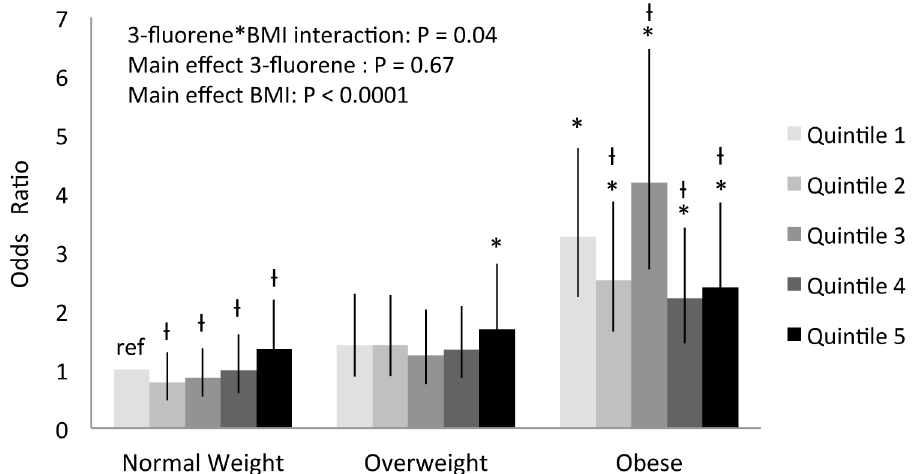
Fig 1. Weighted and adjusted odds ratio for hypertension and 3-fluorene quintiles by weight status. Weighted and adjusted for age, sex, poverty income ratio, ethnicity, smoking status and urinary creatinine. * Significantly different from normal weight in the lowest 3-fluorene quintile (reference group), P (cid:1) 0.05. Ɨ Significantly different from the lowest 3-fluorene quintile within BMI category P (cid:1)